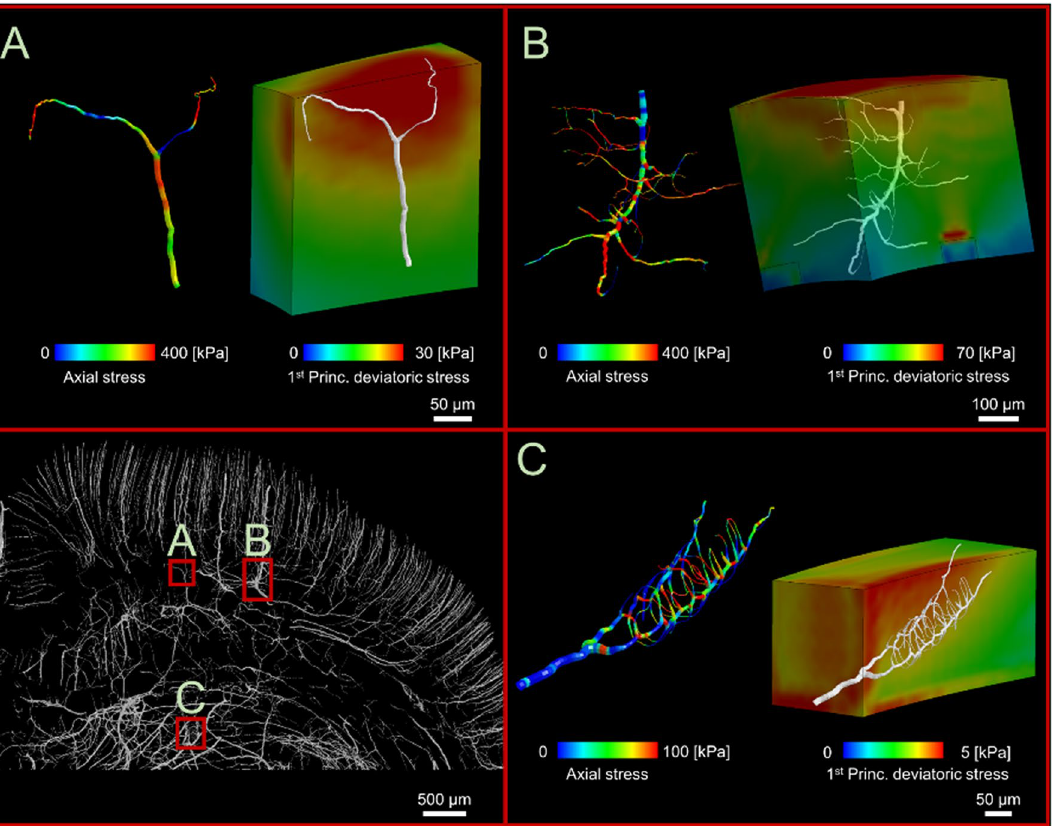
Figure 3. Examples of stress alteration at vessels which are only few microns apart. ( A ) Three different stresses in three branches of a bifurcation point show how the direction of vessels may result in three different levels of vascular stretching. ( B ) Capillaries branching out from a vessel with non-uniform stress distribution due to propagation of capillaries in different directions, ( C ) Capillaries with different stresses even though they are branching out from the same vessels and bifurcation